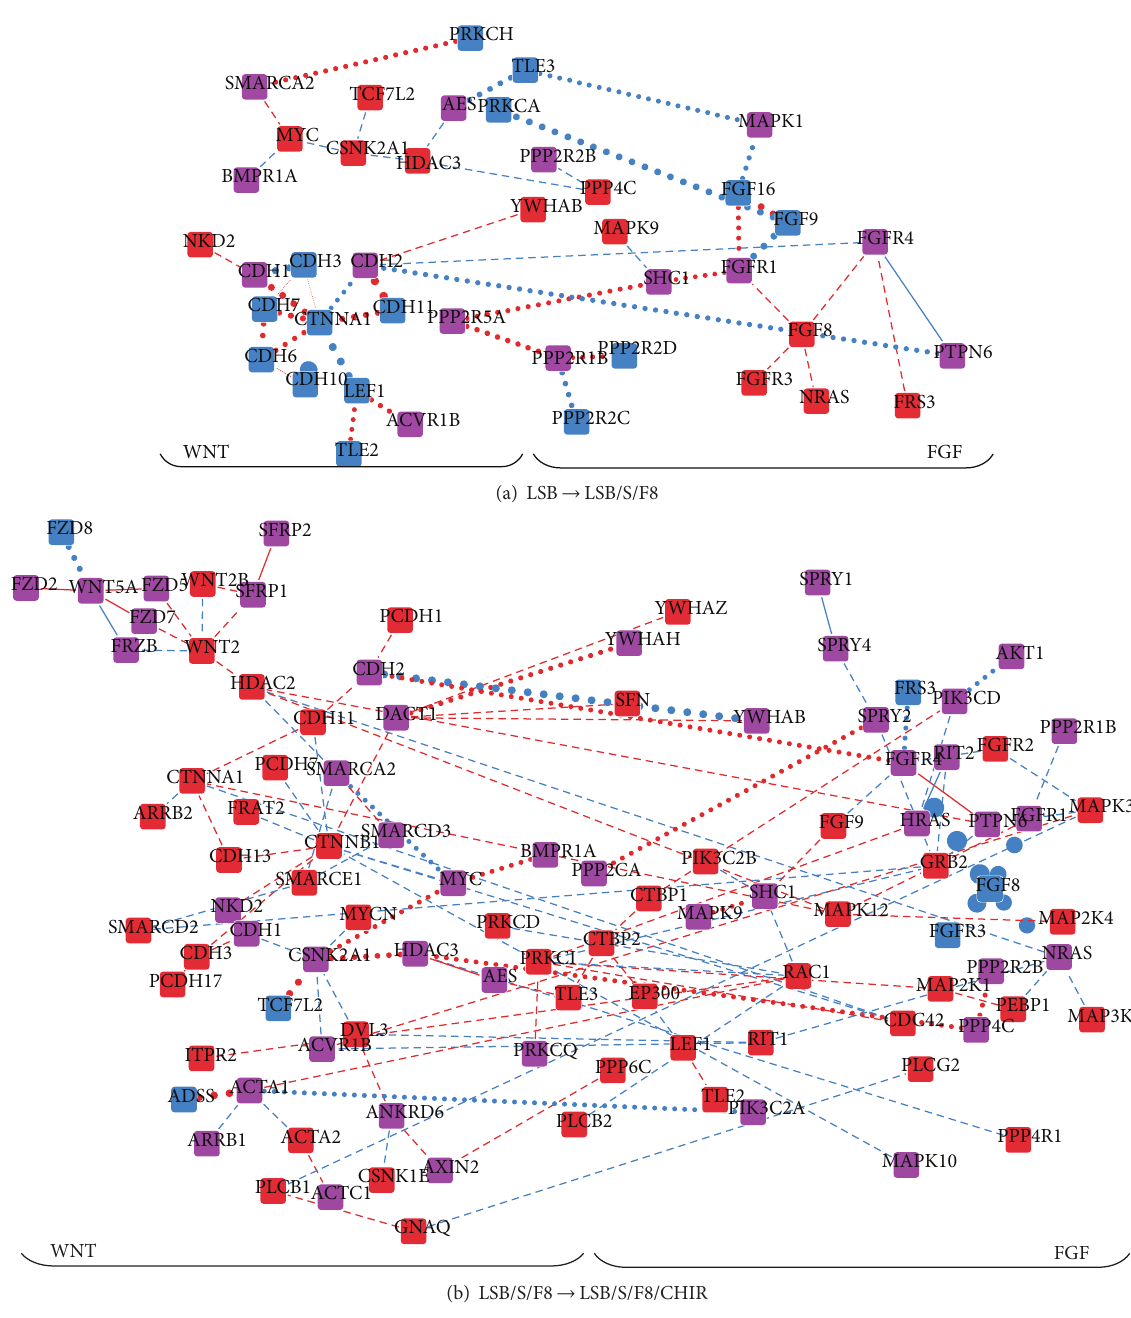
Figure 5: The interaction activity variations of the FGF and WNT functional modules in the directed differentiation process at two differentiation stage transitions. (a) Interaction activity variations from the LSB stage to the LSB/S/F8 stage. (b) Interaction activity variations from the LSB/S/F8 stage to the LSB/S/F8/CHIR stage. Node and edge colors and edge line styles have the same interpretation as in Figure